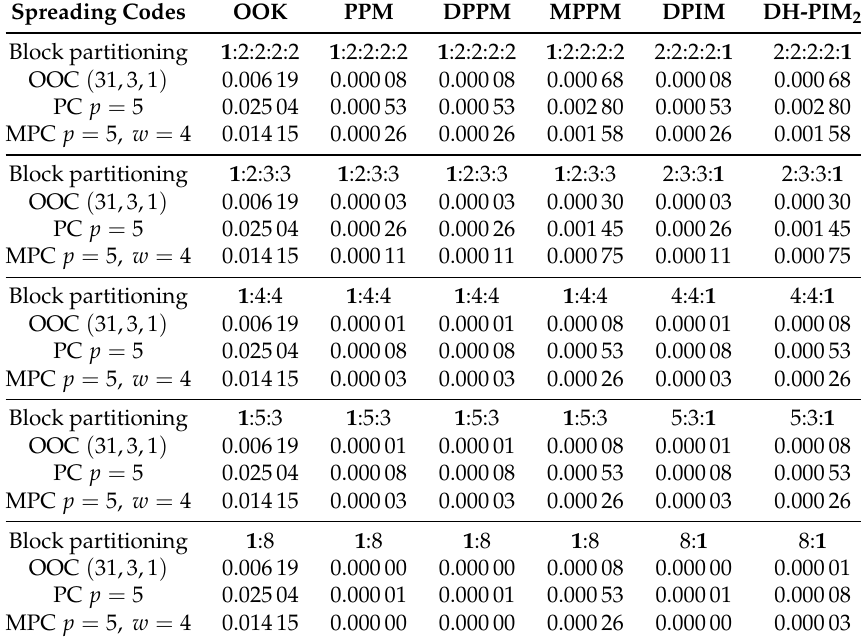
Table 17. Error rate at maximum distance R max as a combination of modulation and spreading